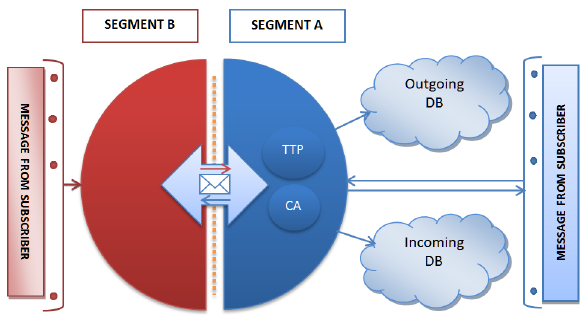
Figure 2: The cross-border information exchange in the integrated